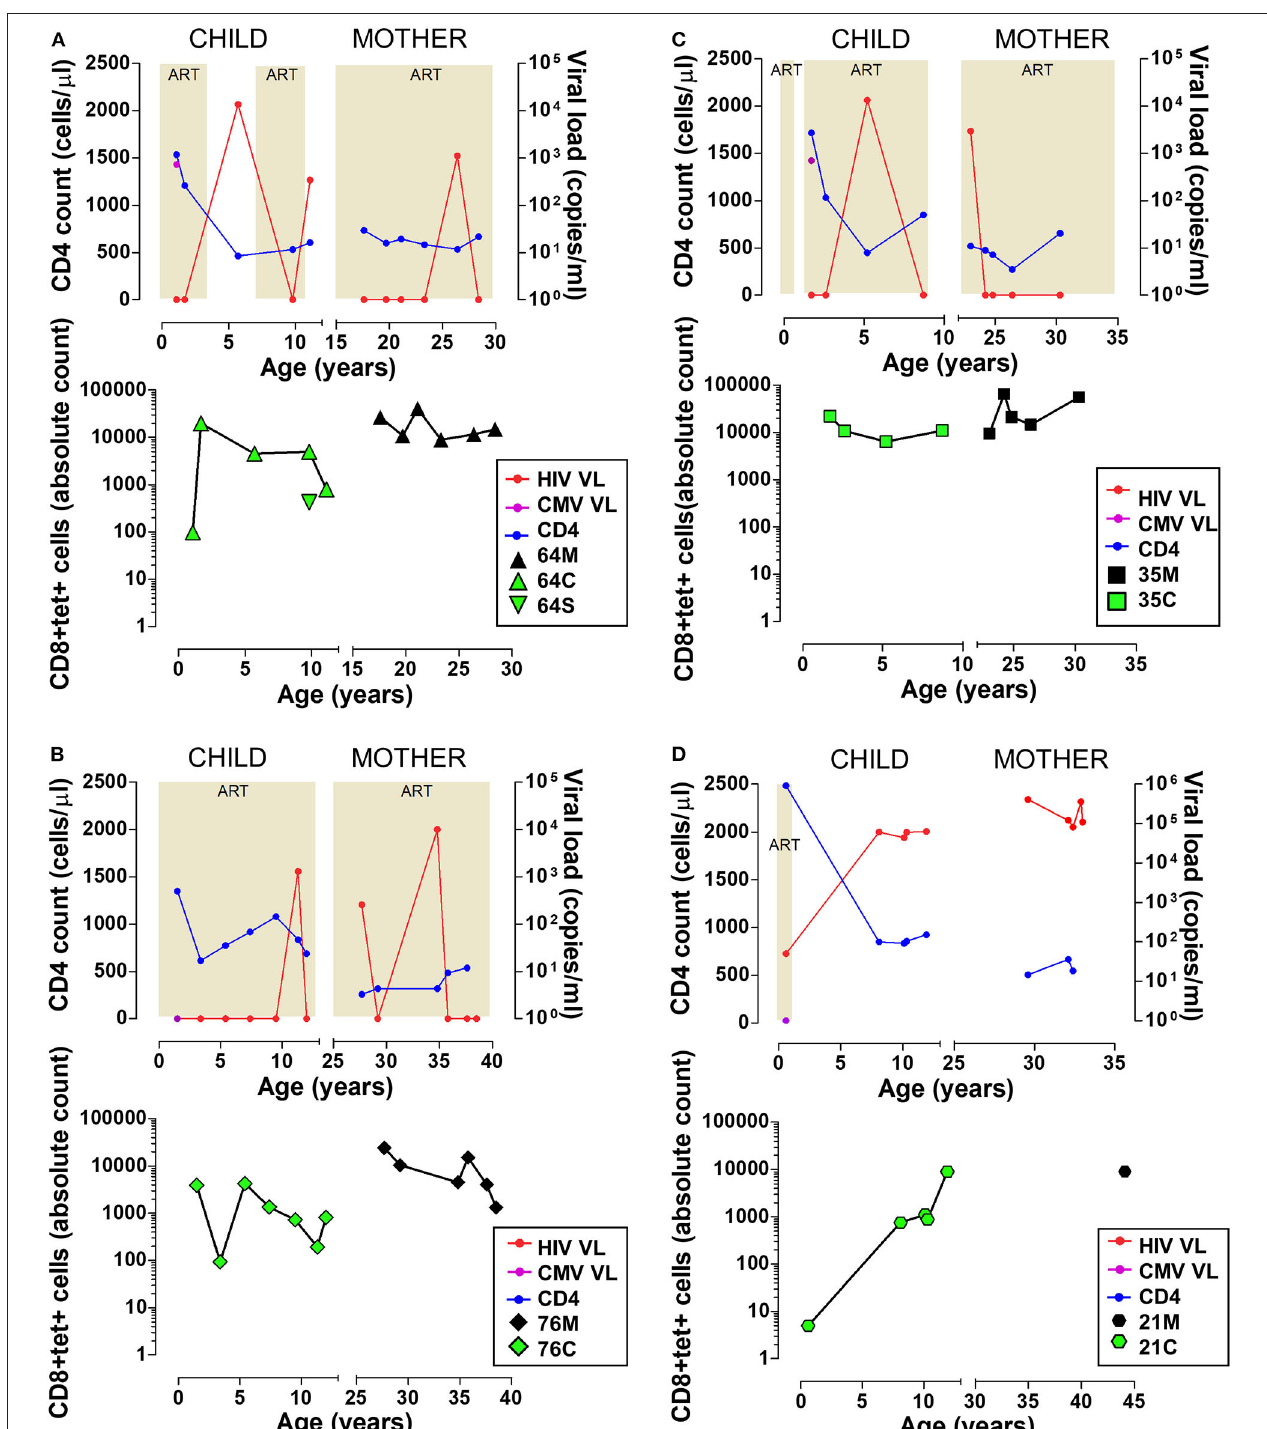
FIGURE 1 | High magnitude HLA-B*44:03-restricted, NW8-specific T cell responses are detectable over 12 + years in four mother-child pairs. Clinical data and frequency of tet + CD8T cells are shown for four mother-child pairs. (A) 64C and 64M, as well as 64S, an HIV-uninfected sibling of 64C. (B) 76C and 76M. (C) 35C and 35M. (D) 21C and 21M. For 21M, only one timepoint was sampled and clinical data was not available. In all panels, data from the child is displayed on the left and data from the mother on the right side. Clinical data (top) includes the CD4 count in blue, HIV viral load in red, and CMV viral load in purple. The shaded areas indicate the periods when the subjects were on antiretroviral therapy. Longitudinal tetramer data (bottom) is shown as green symbols for children, and black symbols for mothers.